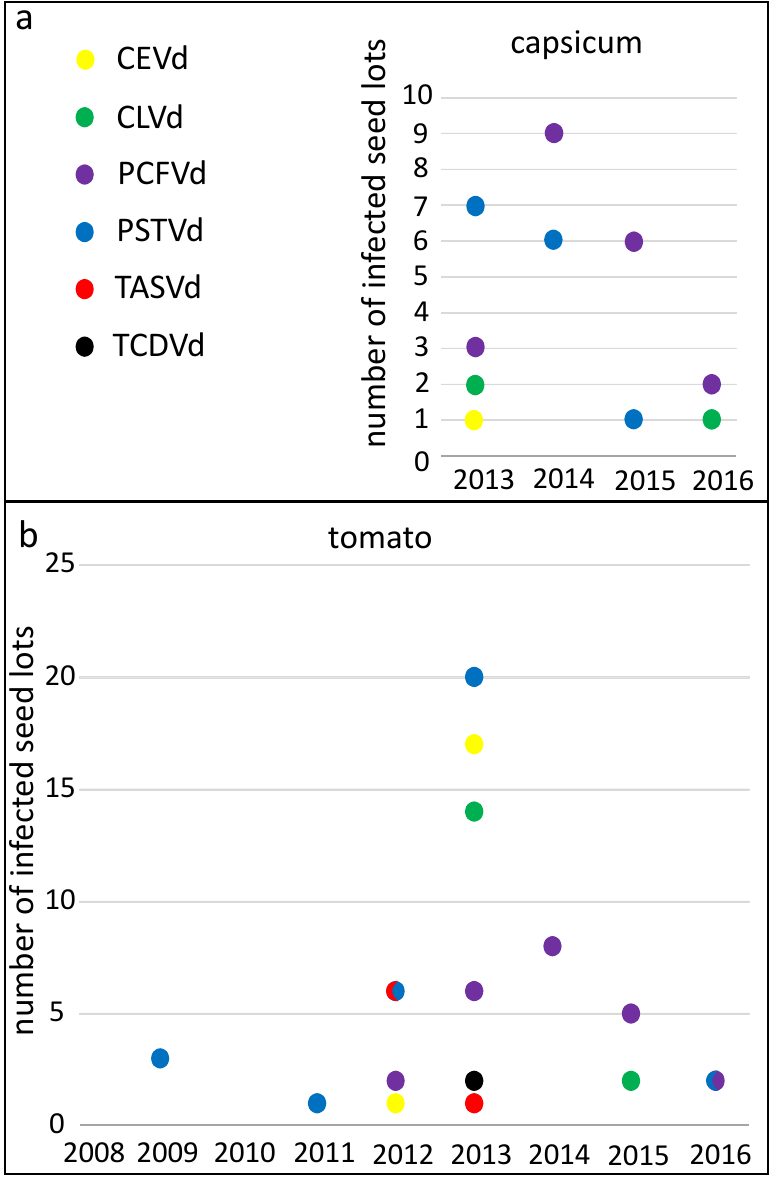
Figure 3. Detections of viroid species in capsicum and tomato seed lots by year. Numbers of detections of viroid species in capsicum ( a ) and tomato ( b ) seed lots. PSTVd (blue) and Tomato apical stunt viroid (TASVd) (red) were both detected six times in tomato seed lots in 2012, and Pepper chat fruit viroid (PCFVd) (purple) and PSTVd (blue) were both detected twice in tomato seed lots in 2016. The partial sequences from 23 PCFVd detections had between 90–100% identity with each other, and several PCFVd sequences sequences from isolates from capsicum and tomato seed lots were identical (Table S1, Figures S3 and S14). The partial sequences from two TASVd detections (195 nt) were 99% identical to each other and had 89–94% identity with 30 sequences recorded in GenBank (Table S1, Figure S4). The partial sequences from eight TCDVd detections (150 nt) had 95–100% identity with each other (Table S1, Figures S5 and S10). Four identical TCDVd sequences originated from four seed companies and three different geographic